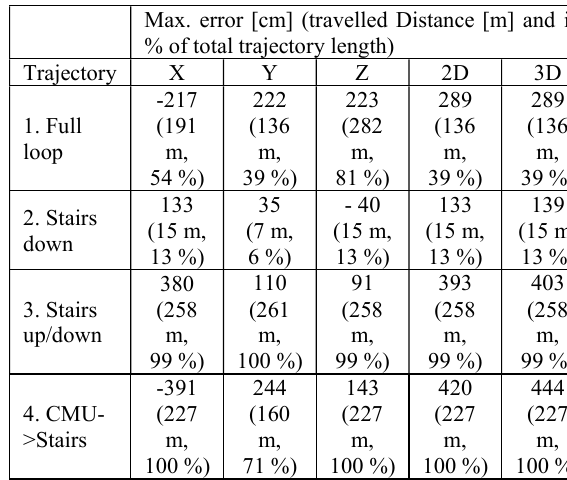
Table 2. Maximum errors with respect to the travelled distance